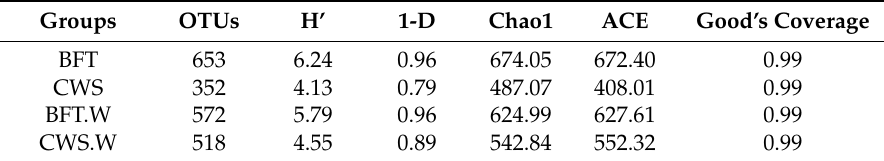
Table 1. Bacterial communities’ diversity and richness in the midgut of Litopenaeus vannamei reared in Biofloc technology (BFT) or clear seawater system (CWS) and after a viral challenge. Groups OTUs H’ 1-D